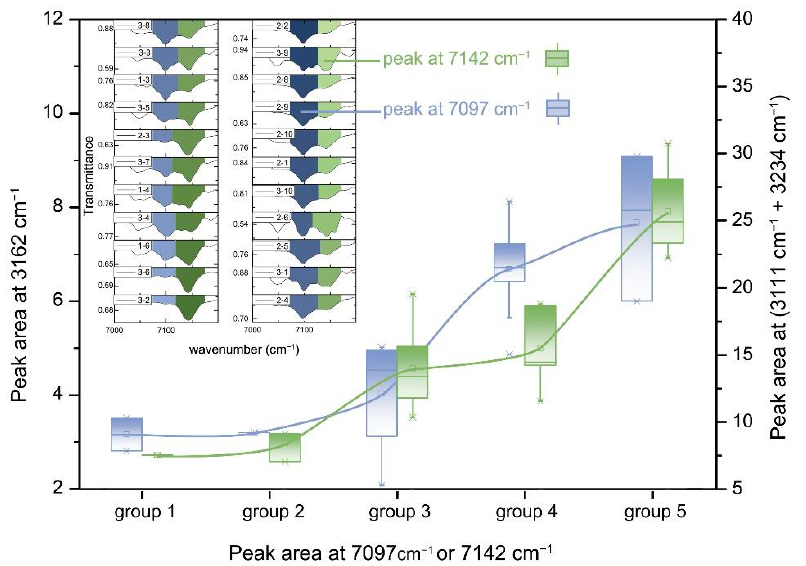
Figure 8. The peak area at 7097 cm −1 was positively correlated with the peak area at 3162 cm −1 , as shown by the blue boxes. The peak area at 7142 cm −1 was positively correlated with the peak areas at 3111 cm −1 + 3234 cm −1 , as shown by the green boxes. The upper left corner was the IR absorption spectrum within the range of 7000–7200 cm −1 . The blue shaded part represented the absorption peak at 7097 cm −1 , and the green shaded part represented the absorption peak at 7142 cm −1 .